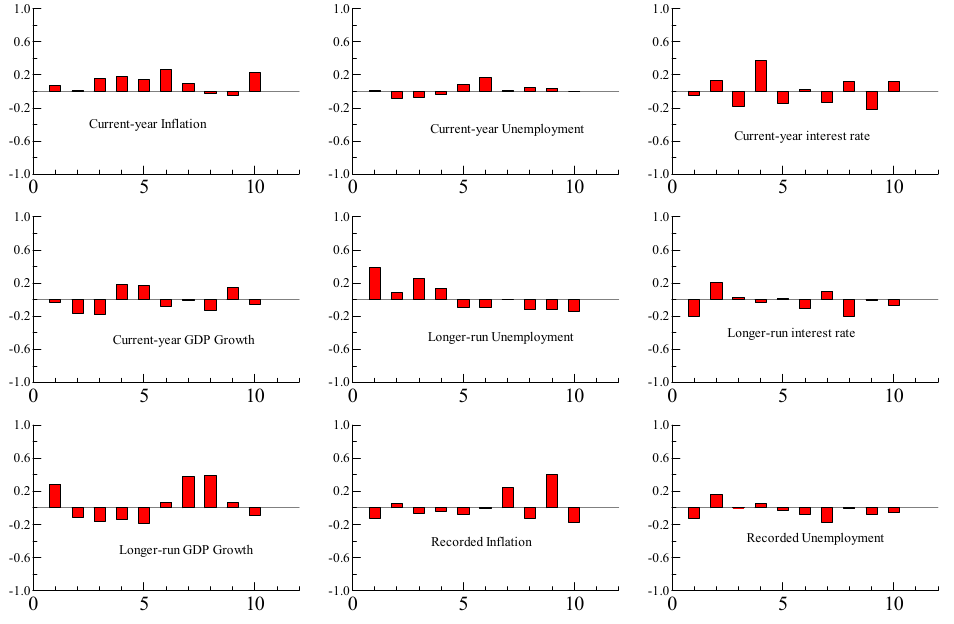
Figure A4. Autocorrelation of residuals squared. To assess the extent to which the empirical distributions of the residuals are normal, Figure A5 shows the empirical distribution of the scaled residuals and compares them to the N(0,1) distribution. Apart from the distributions for the current-year forecasts for in- flation and the appropriate interest rate, the results suggest that deviations from normality are small.